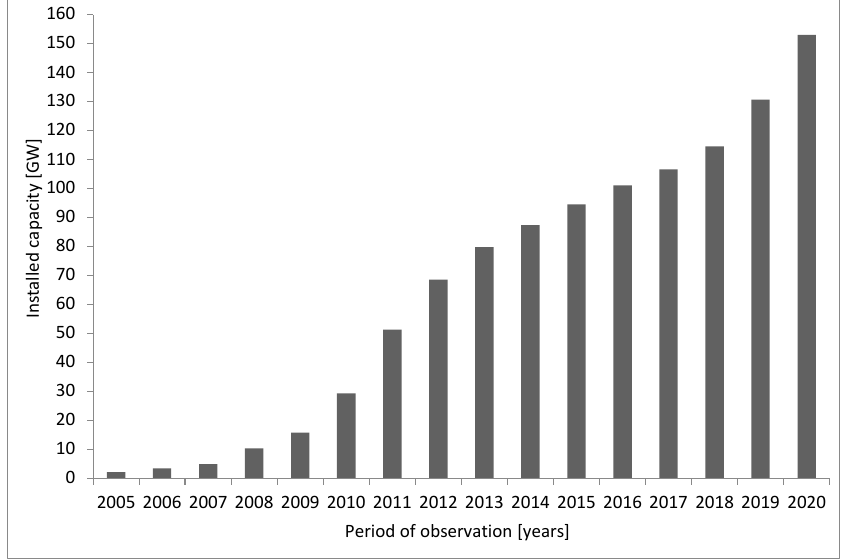
Figure 2. Installed photovoltaic capacity in the European Union, on the basis of [10].